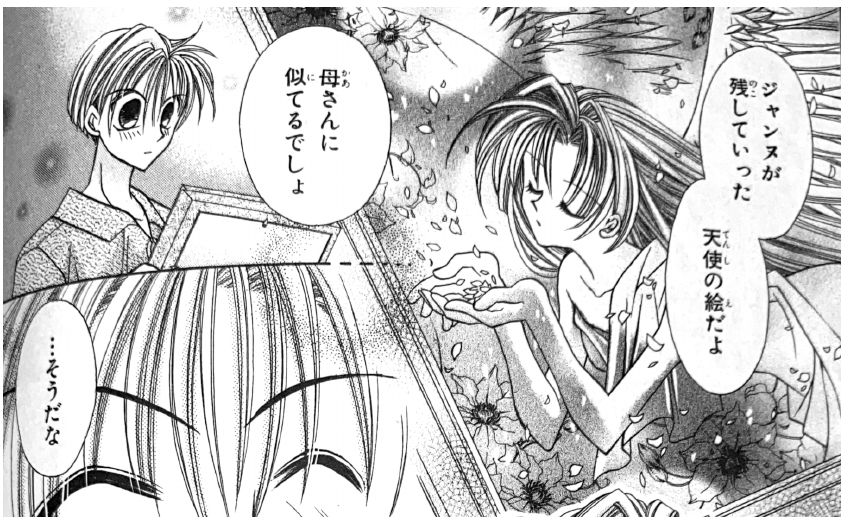
Figure 7 Image that appeared after Jeanne stole a painting and left an image of an angel that resem- bles the mother of the owner of the vanished artwork (Tanemura